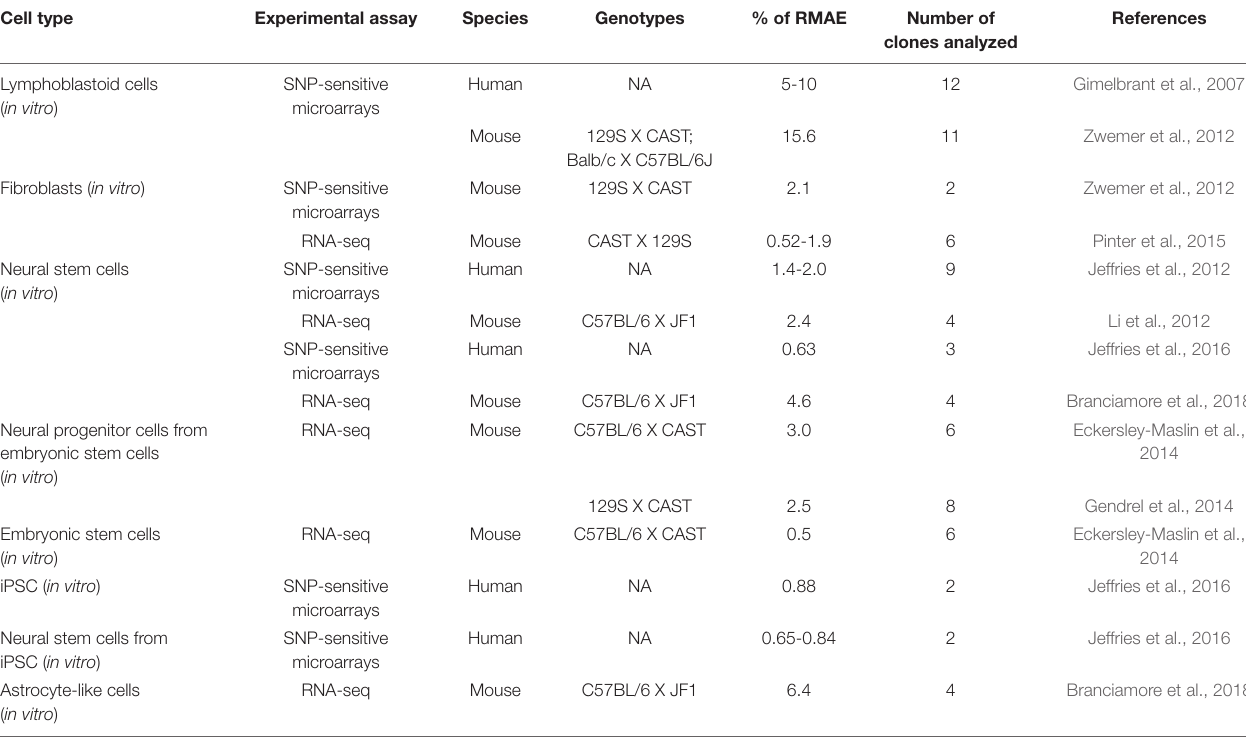
TABLE 2 | A summary of reports based on genome-wide transcriptomics analysis in different cell